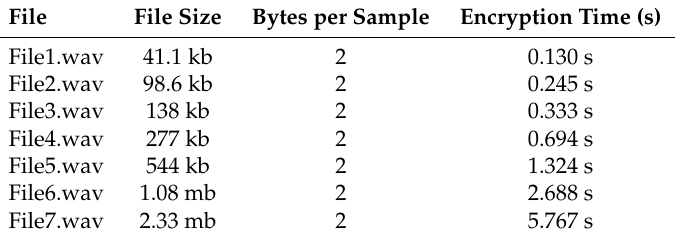
Table 8. Speed performance